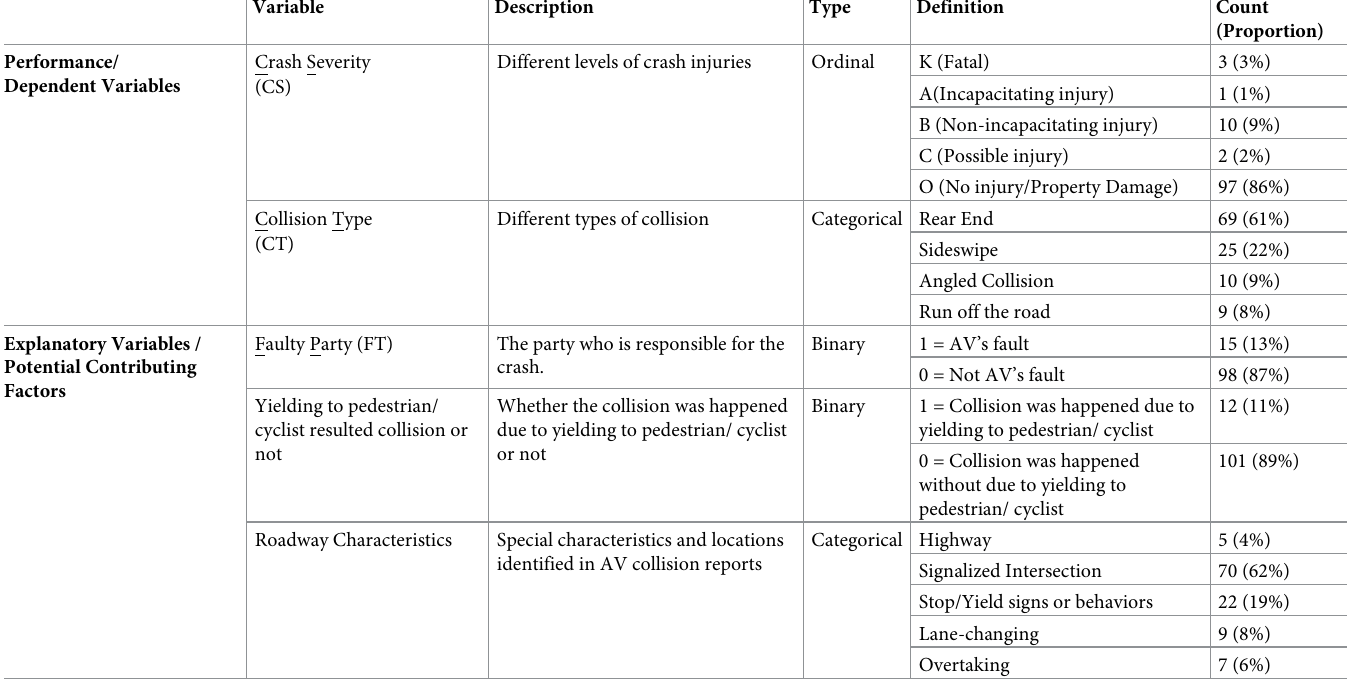
Table 1. AV crash data